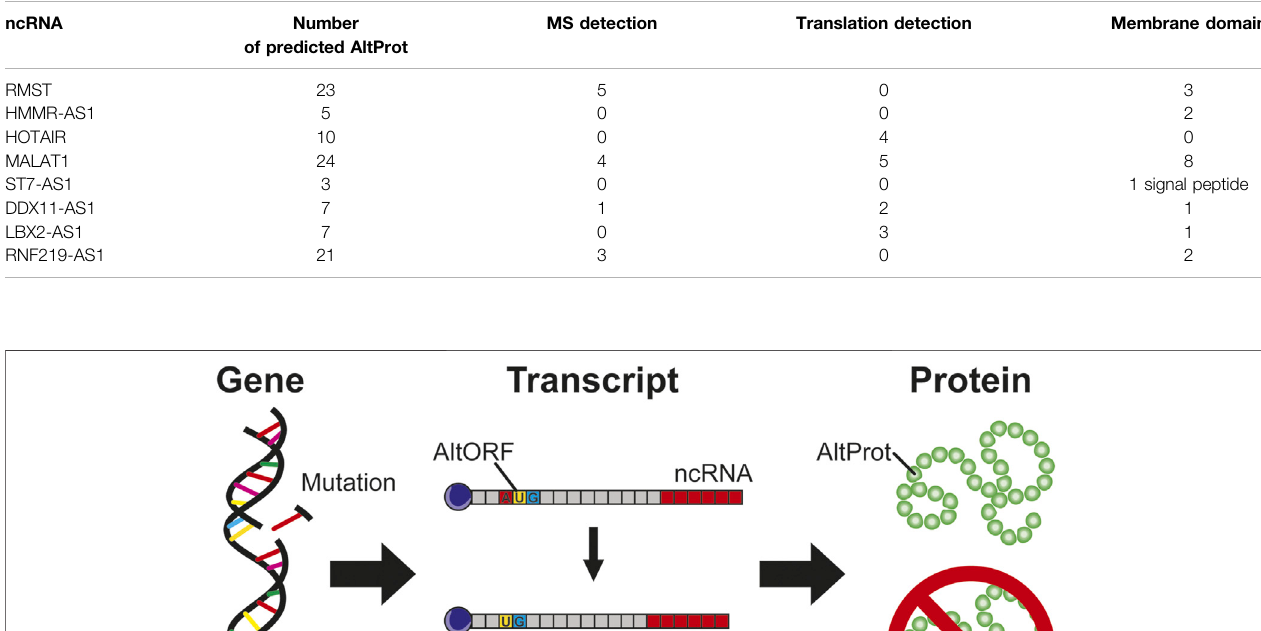
Frontiers in Cell and Developmental Biology |